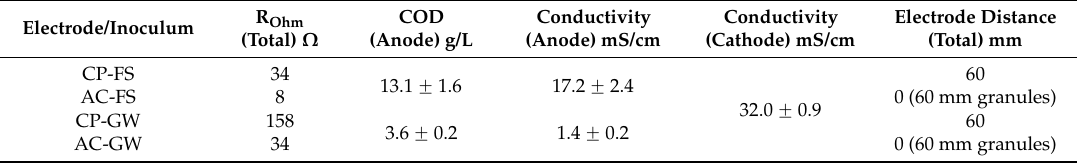
Table 1. Electrochemical impedance spectroscopy (EIS) result (R Ohm ), chemical oxygen demand (COD), conductivity and electrode distance determined after adding the substrate. CP forms a flat sheet while the palm kernel shell AC forms a 6 cm thick granular layer.